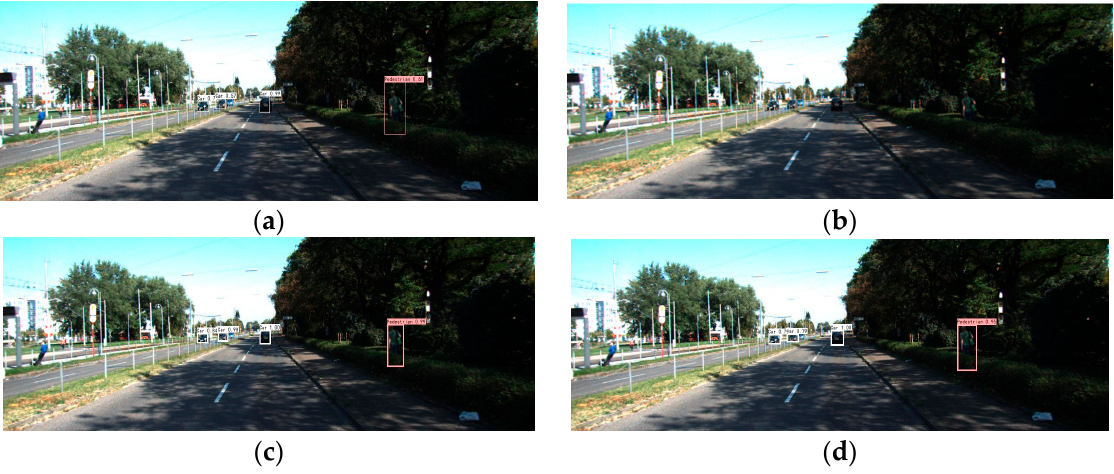
Figure 8. Small target scenes. ( a ) Faster R-CNN detection effect, ( b ) SSD detection effect, ( c ) YOLOv3 detection effect, ( d ) MobileNetv2_CA detection effect.